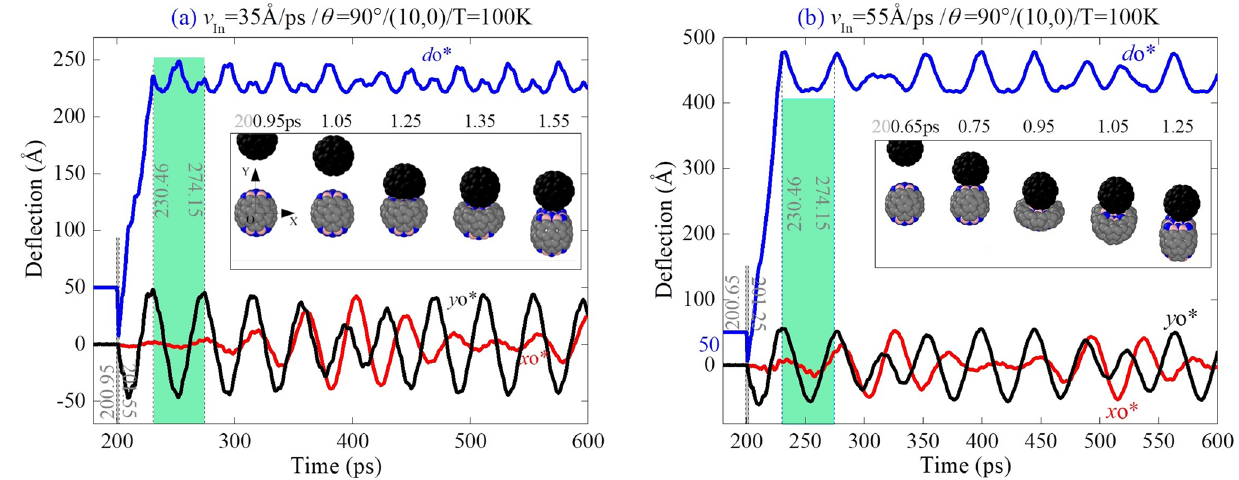
Figure 2. Vibration of the (10,0) beam tip (cross section 1) and motion of C 60 before and after collision with different incident velocities of ( a ) v In = 35 /ps, and ( b ) 55 /ps when θ = 90° at 100 K. o * is the centroid of cross section 1 in the beam. “ d o * ” (blue curves) is the distance between the centroid of C 60 and o * with coordinates of Å Å x o* (red curves), and y o* (black curves) in the vibration planes. Insets are snapshots during collision.